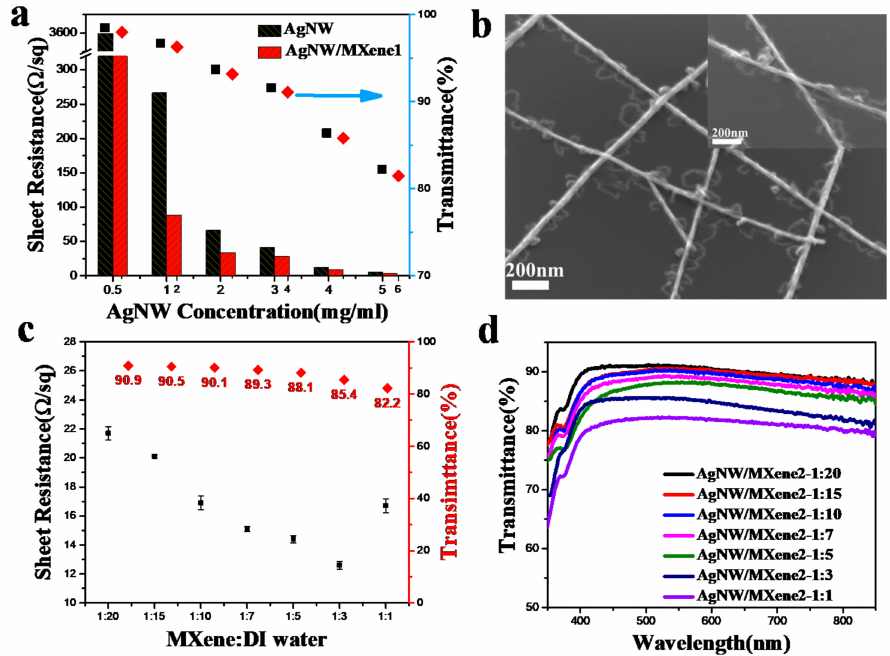
Figure 2. ( a ) The photoelectric properties of pristine AgNWs film and hybrid films with different AgNW concentrations. ( b ) Low-and high-magnification SEM images of the Ti 3 C 2 T x nanosheets on the AgNW network (AgNW/MXene1). ( c ) Sheet resistances and transmittances of the hybrid films under different MXene contents after second coating (AgNW/MXene2). ( d ) Optical transmittance of AgNW/MXene2 hybrid TCFs with various